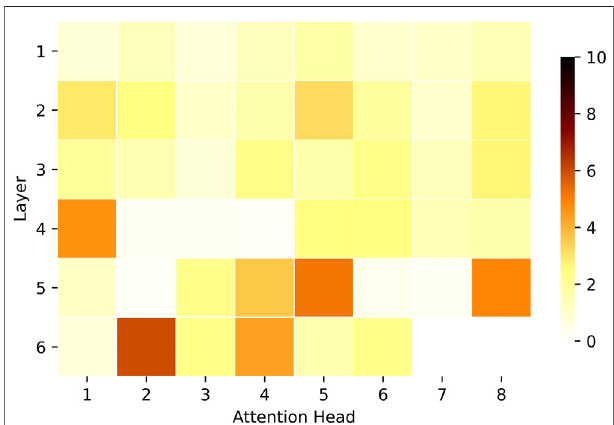
FIGURE 11 | The proportion of attention links between target and source objects which can be associated with at least one noun in the caption. The nouns cannot be identical (e.g., “ cows ” and “ building ” in “ two cows outside, one laying down and the other standing near a building ” ), and both the target and the source objects linked with them must correspond to two different thematic clusters. Forbetter visualisation, the highest value isset to